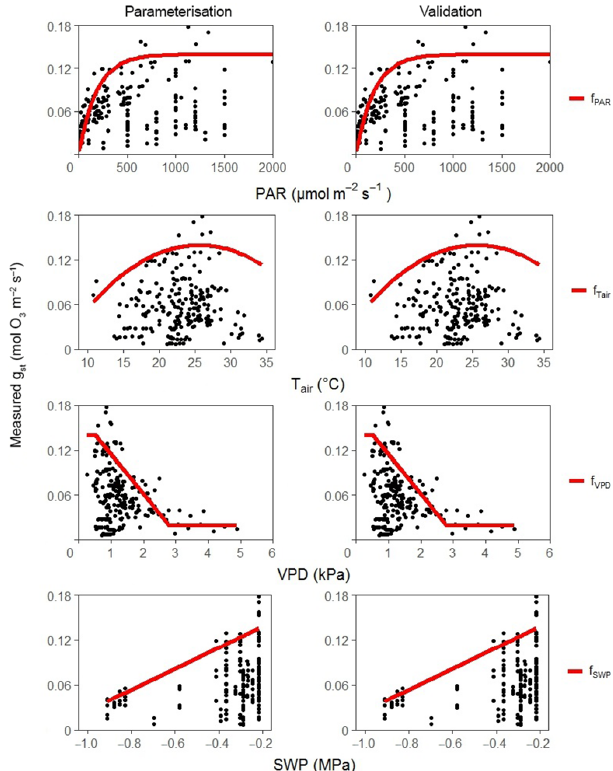
Figure 5. The measured stomatal conductance ( g st ) as a function of the different variables used in the multiplicative model: photo- synthetically active radiation (PAR), air temperature ( T air ) , vapour pressure deficit (VPD), and soil water potential (SWP). The red line represents the boundary line for which the functions are given in Appendix B (Eqs. B3–B6) ( n = 205).